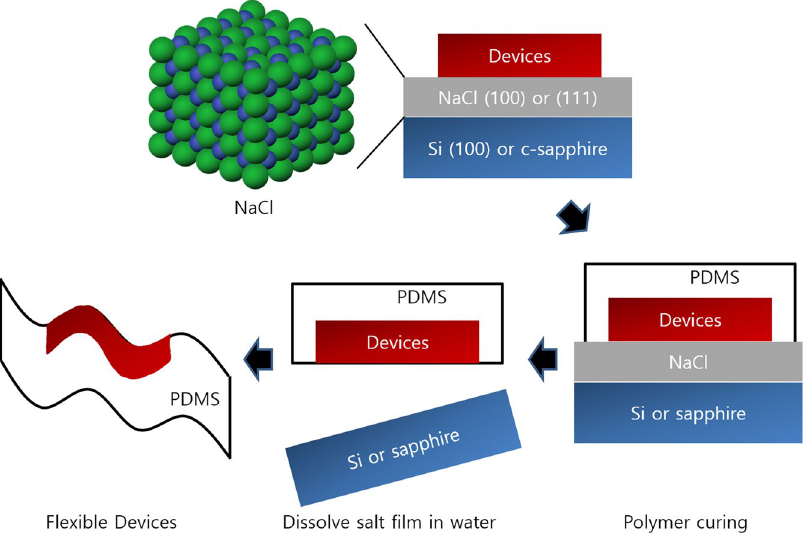
Figure 1. Schematic showing the experimental procedure for the fabrication of flexible devices based on water- soluble NaCl sacrificial layer.